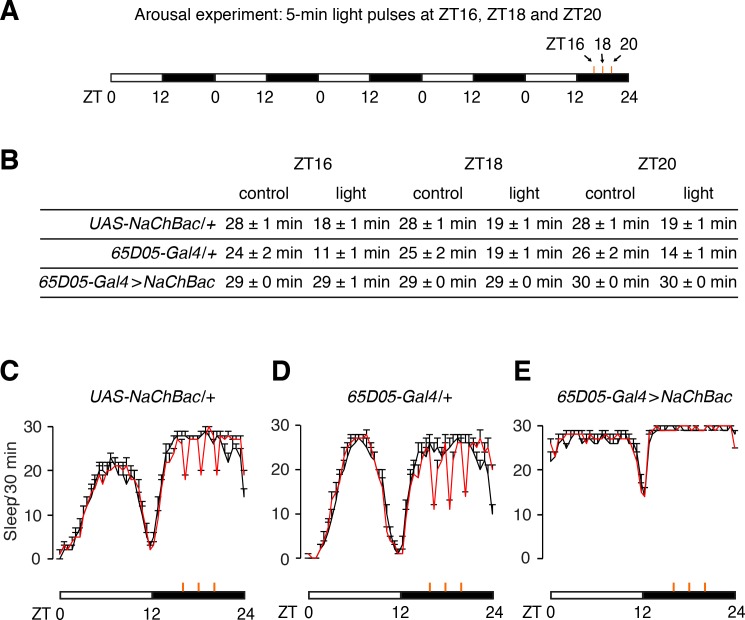
Arousal effects of 5 min light delivered at ZT16, ZT18, and ZT20.(A) Paradigm for testing arousal. Flies were maintained for five days under 12 hr light/12 hr dark cycles. On the 5th night we exposed the flies to three 5 min light pulses delivered at ZT16, ZT18, and ZT20. The white and black horizontal bars indicate the day/night cycles and the small orange vertical bars indicate the light pulses. (B) Reductions in sleep during the 30 min period following the onset of the light stimuli. Each 30 min period includes the 5 min light pulse plus the following 25 min. Control, the sleep time during the same 30 min period of the 4th night. (C—E) Sleep profiles of the indicated flies during the 4th and 5th days. The profile during the 4th day (black traces) establishes baseline sleep (black line) and the profile during the 5th day (red) includes the effects on sleep (arousal) due to the three 5 min light pulses (orange traces). n = 24 for all flies. Error bars, SEMs.